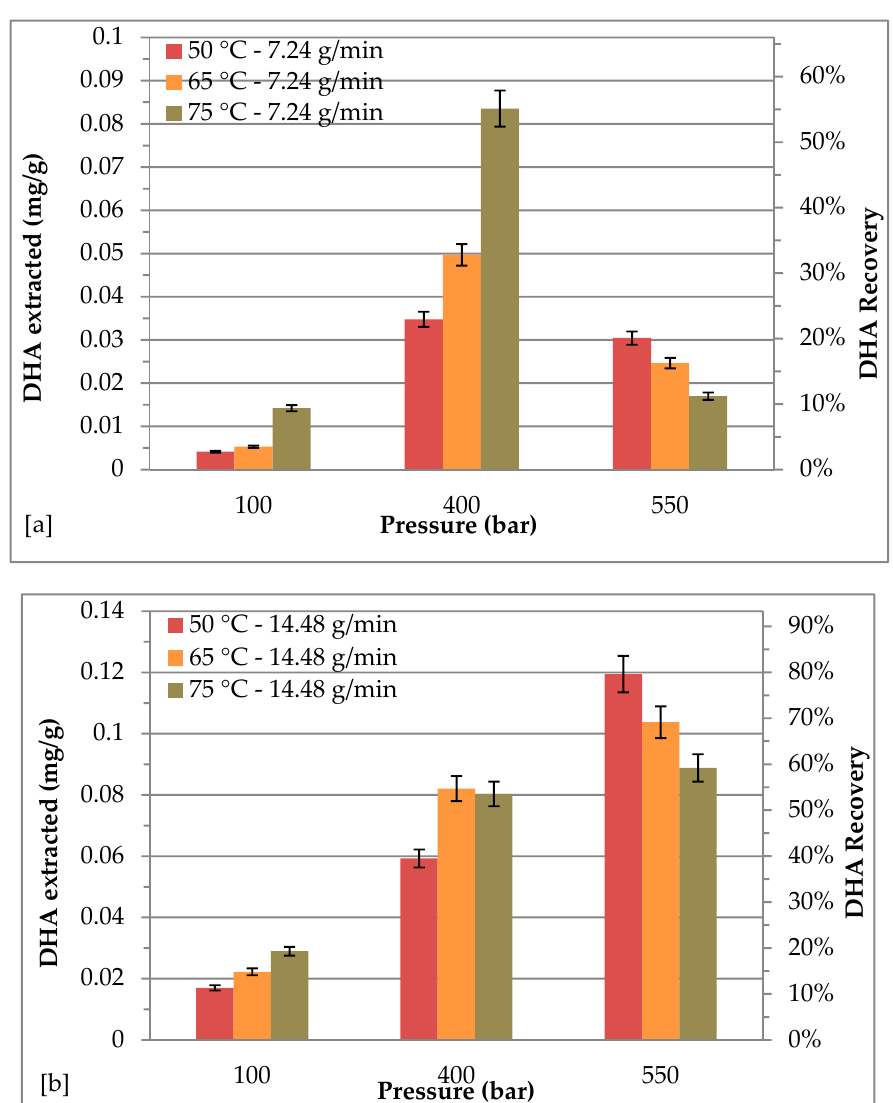
Figure 3. Effect of different pressure and temperature on recovery of DHA: ( a ) CO 2 flow rate = 7.24 g/min; Figure 3. E ff ect of di ff erent pressure and temperature on recovery of DHA: ( a ) CO 2 flow rate = ( b ) CO 2 flow rate = 14.48 g/min. 7.24 g / min; ( b ) CO 2 flow rate = 14.48 g /